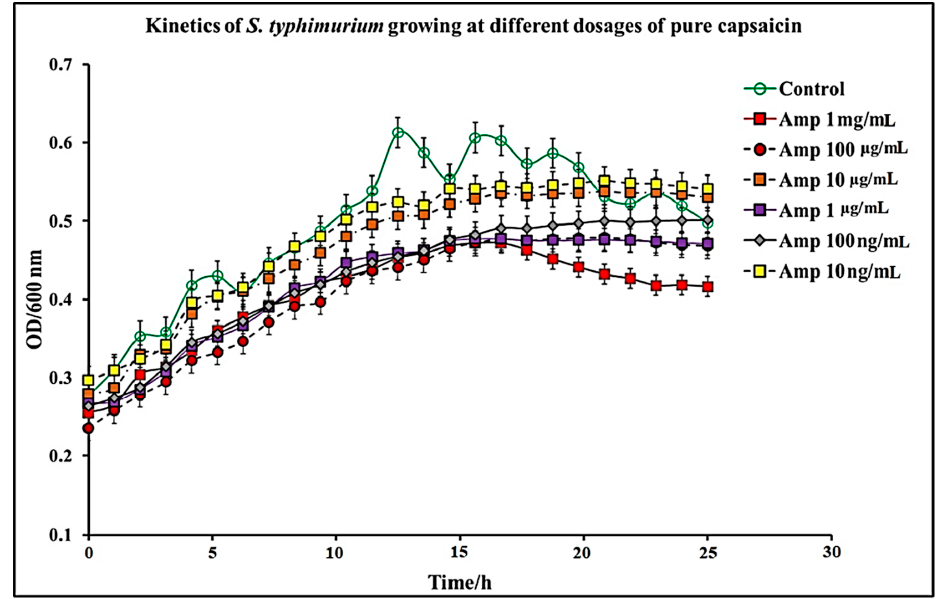
Figure 2. Kinetics of S. typhimurium growth at varying dosages of pure capsaicin. The results represent the average of three independent experiments ± standard deviation.